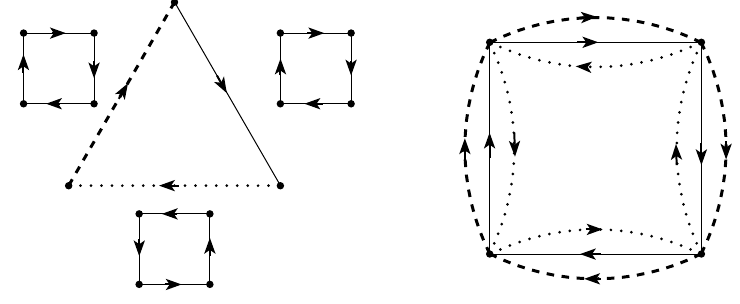
) −→ Γ and the multidigraph M h 3